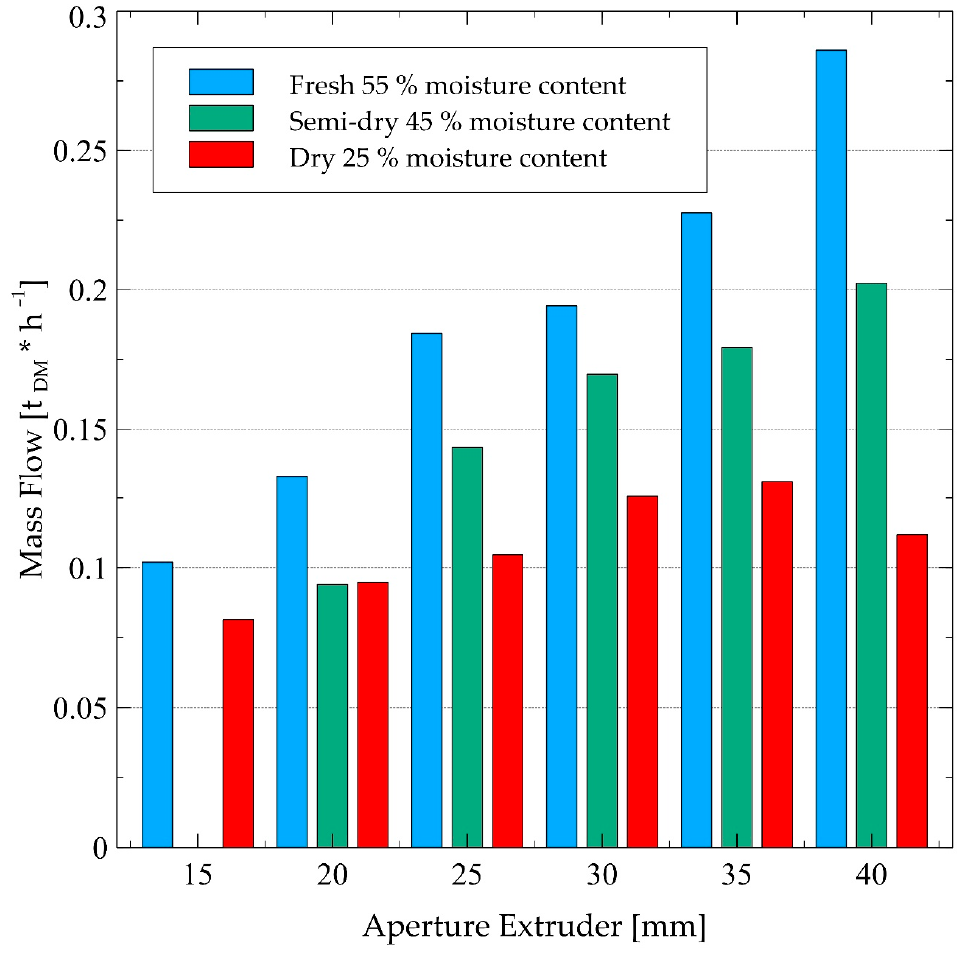
Figure 5. Dry matter mass flow of each raw material at all apertures.